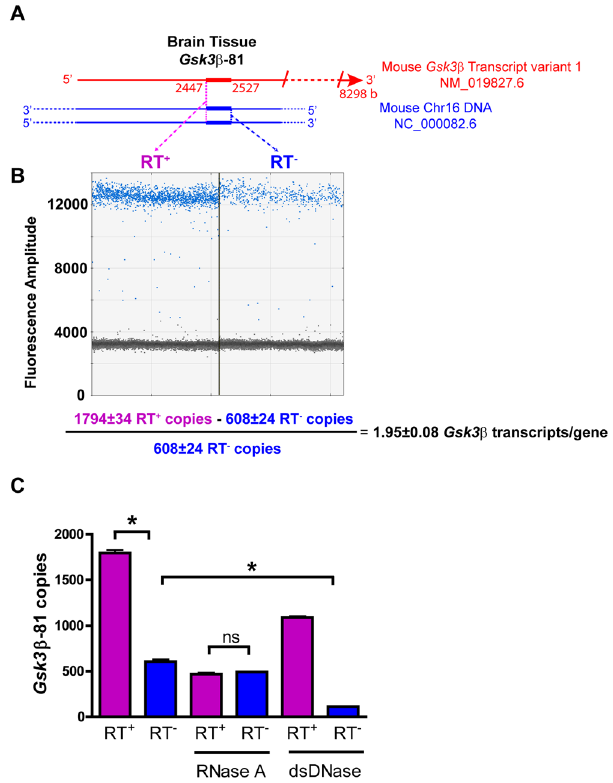
Figure 2. Validation of Selfie-dPCR for gene transcription in brain tissue. ( A ) Schematic diagram showing the location of the Gsk3 β -81 amplicon within mouse Gsk3 β RNA and DNA and illustrating Selfie-dPCR amplification of RNA + DNA in the RT + reaction and only DNA in the RT − reaction for each amplicon. ( B ) Scatter plot showing copy number analysis by droplet digital PCR of Gsk3 β genes + Gsk3 β transcripts (RT + , left panel) and only Gsk3 β genes (RT − , right panel) present in brain tissue lysate. Blue dots indicate droplets with a fluorescence amplitude above (positives) and gray dots indicate droplets with a fluorescence amplitude below (negatives) the threshold. Positive droplets indicate the presence of target within the droplet, in which end-point PCR produced an amplicon. The ratio of the positive to the total number of droplets allows for calculation of the number of copies of Gsk3 β in the sample by using a Poisson function 14 . The formula below shows the calculation of the number of Gsk3 β transcripts per gene, which equals the number of Gsk3 β copies obtained in the RT + aliquot minus the RT − aliquot divided by the RT − aliquot. ( C ) Treatment with RNase A shows that the difference between RT + and RT − is due to Gsk3 β RNA in the sample. Treatment with dsDNase shows that the number of Gsk3 β copies is due to the presence of dsDNA in the sample. The reduction of Gsk3 β copies in RT + treated with dsDNase is equivalent to the amount of DNA present in the sample. The copies of Gsk3 β in the RT + sample treated with dsDNase are equivalent to the amount of RNA that when added to the amount of DNA in the untreated RT − condition, is not significantly different from the amount obtained for the simultaneous measurement of RNA + DNA in the untreated RT + sample. * , significantly different, p < 0.01; ns, non-significant difference, n =